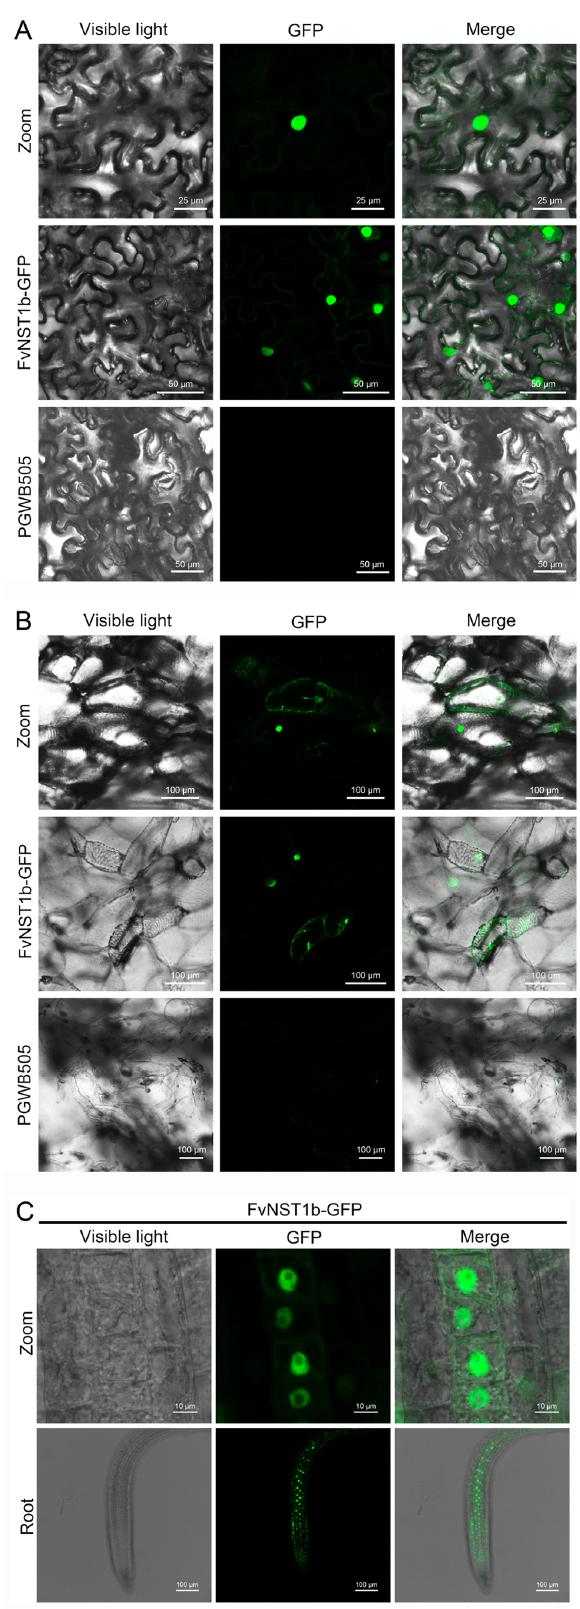
Figure 3. Subcellular localization of FvNST1b–GFP fusion protein. The tobacco leaf cells, strawberry fruit cells, and Arabidopsis were transformed with the plasmid FvNST1b–GFP or with the control vector with GFP. ( A ) Subcellular localization of FvNST1b-GFP fusion protein transiently expressed